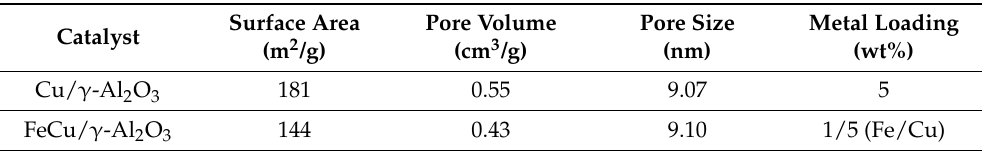
Table 1. BET surface area, pore volume, and average pore size for the samples. Pore volume and diameter calculations were determined using the BJH model on desorption